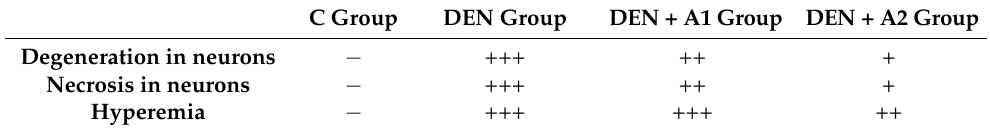
Table 1. H&E staining scores of brain tissues. C Group DEN Group DEN + A1 Group DEN + A2 Group Degeneration in neurons − +++ ++ + Necrosis in neurons − +++ ++ + Hyperemia − +++ +++